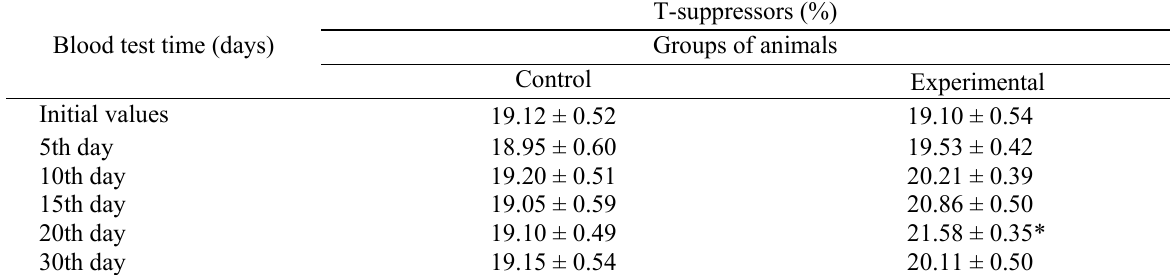
The number of T-suppressors in the blood of bulls under the influence of chronic cadmium toxicosis (М ± m, n = 5)